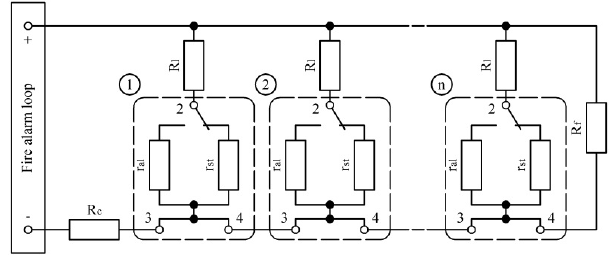
Figure 13. Equivalent electrical circuit of the FAL with normally-open smoke FA r st -resistance of the FA in standby mode; r al -resistance of the FA in alarm mode